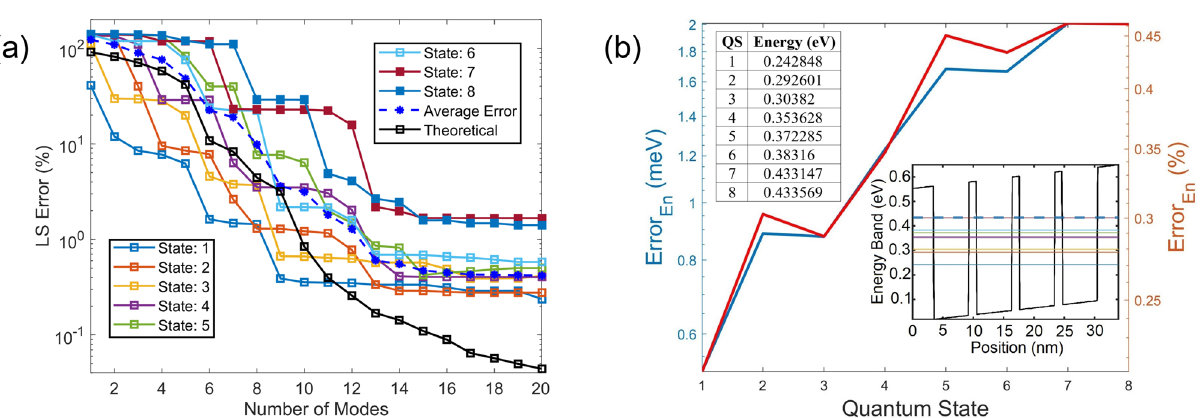
Figure 5. ( a ) POD LS errors for WFs in QSs 1–8. The average POD LS error is averaged over the 6 trained QSs, and the theoretical LS error Err M , ls is identical to that in Fig. 2. ( b ) Absolute error of the estimated POD eigenenergy with two insets of the eigenenergy obtained from the DNS, one in a table and the other in a band diagram along the diagonal direction of the QS structure from (0,0) to (24 nm,24